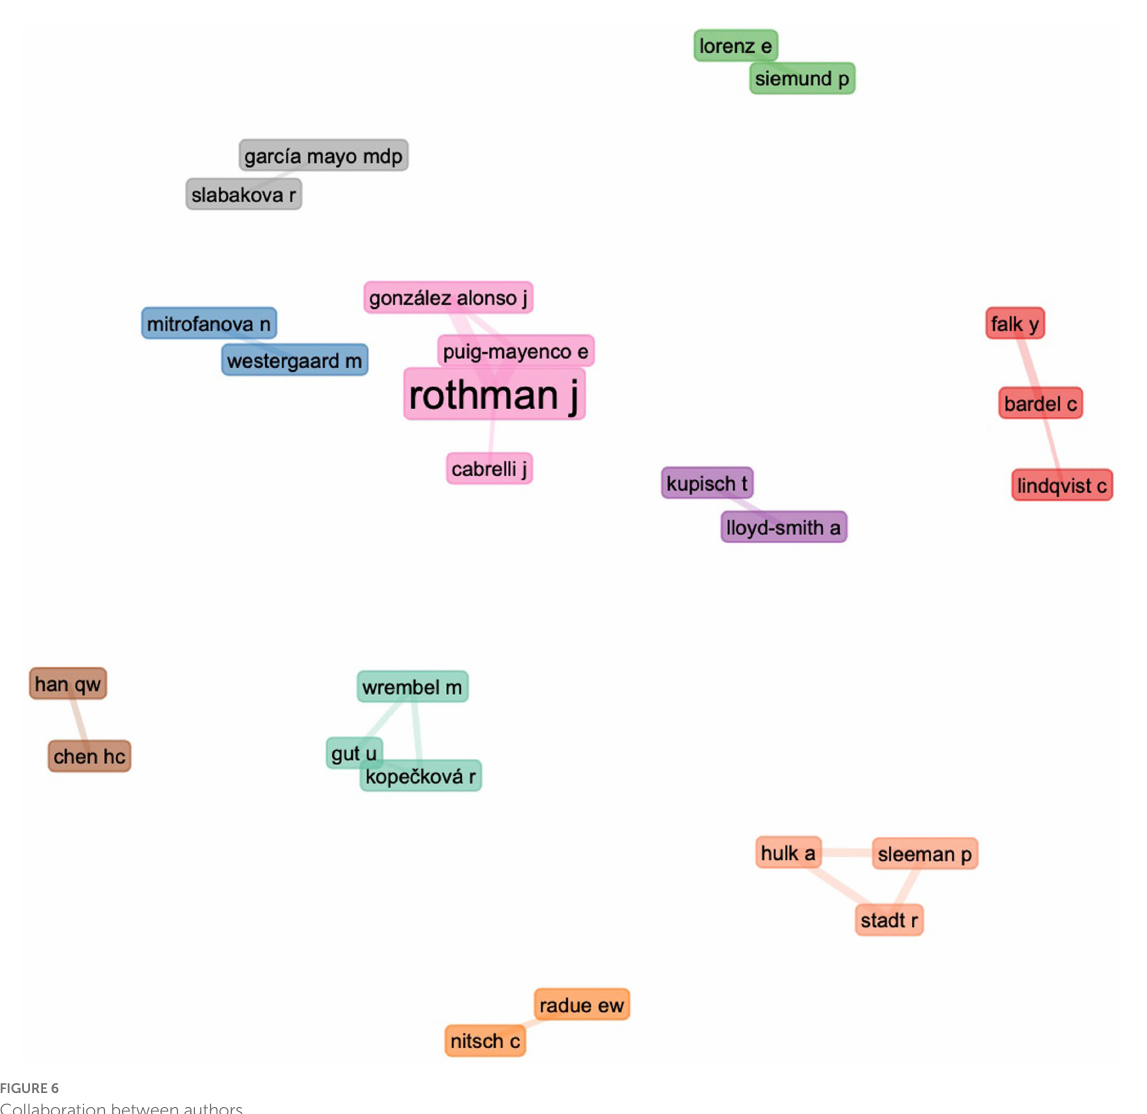
FIGURE 6 Collaboration between